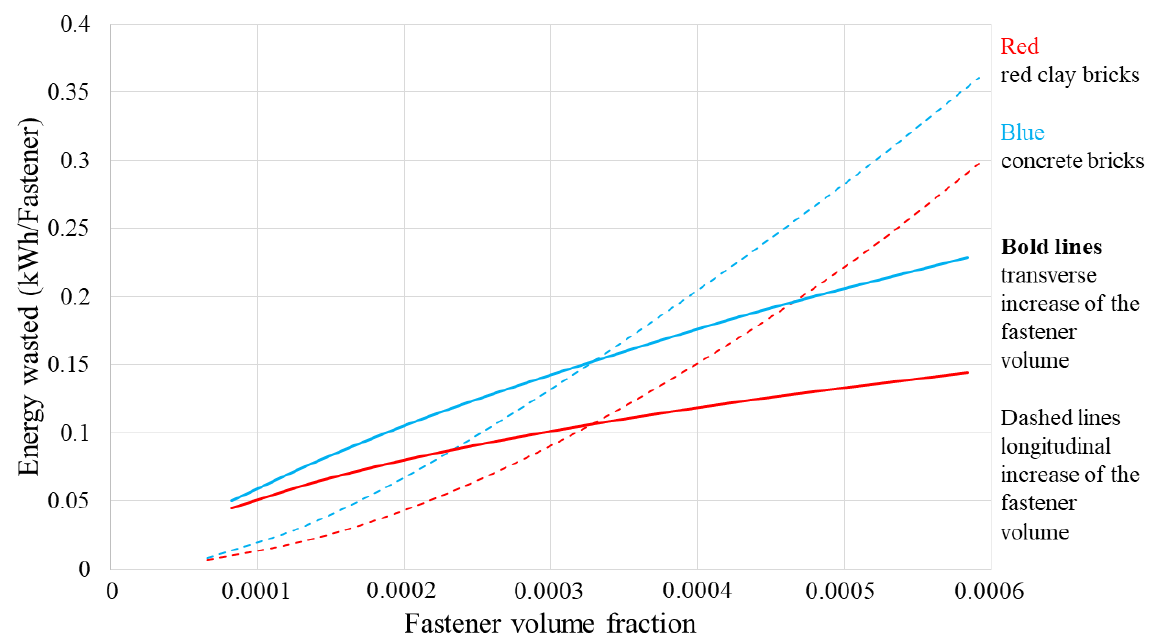
Figure 3. Energy wasted per fastener as a function of fastener volume fraction.